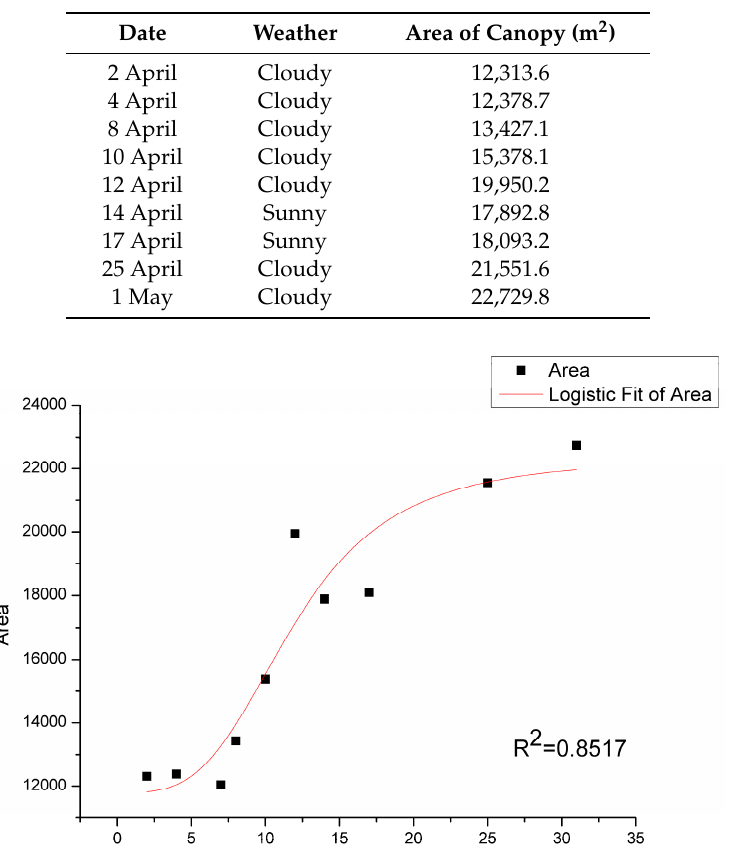
Table 1. The changes of canopy area in the whole study area from 2 April to 1 May 2019.